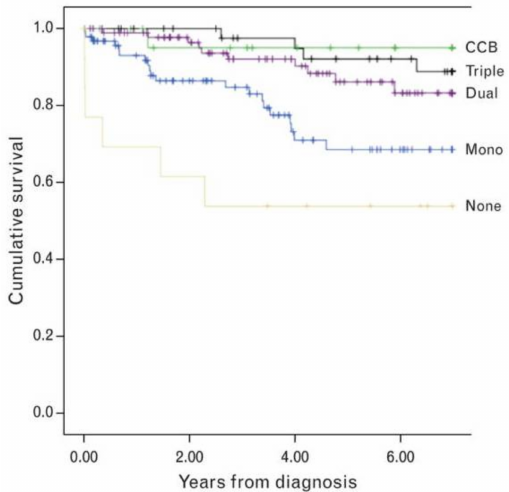
Figure 15. Survival according to extent of pulmonary hypertension therapy in 275 recently diagnosed consecutive pediatric PAH patients at 3 referral centers between 2000 and 2010. Survival improves on combination therapy for pulmonary hypertension over monotherapy. CCB, calcium channel blocker [4].